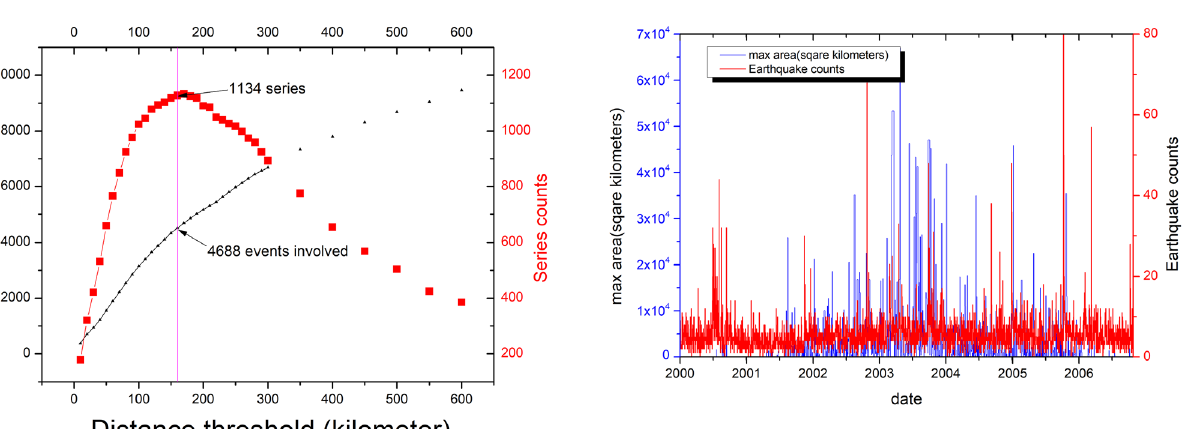
Fig. 10 The series durations (left) and the related disasters along the x axis (right) (restricted by 30, 40, 50, … , 100-km thresholds and a 2-day time threshold)